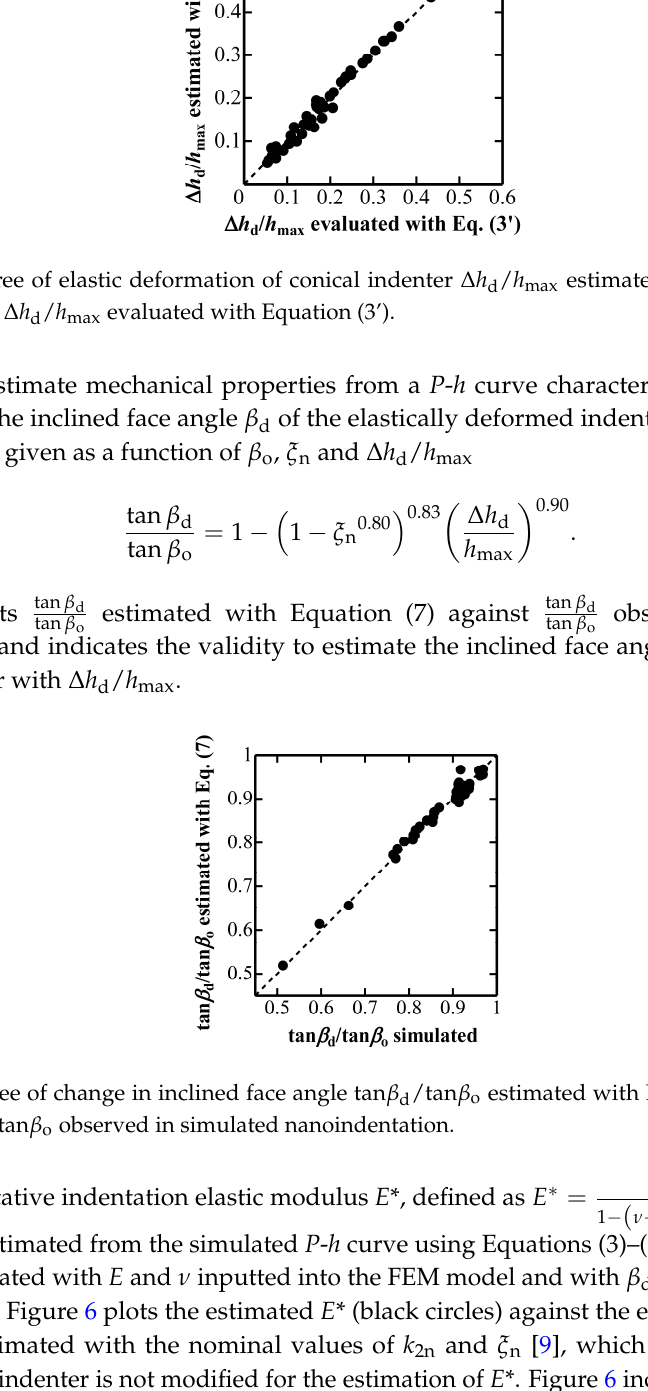
Figure 3. Indentation unloading parameter k 2 simulated and k 2n nominally observed plotted against k 2 evaluated with mechanical properties inputted into the FEM model.